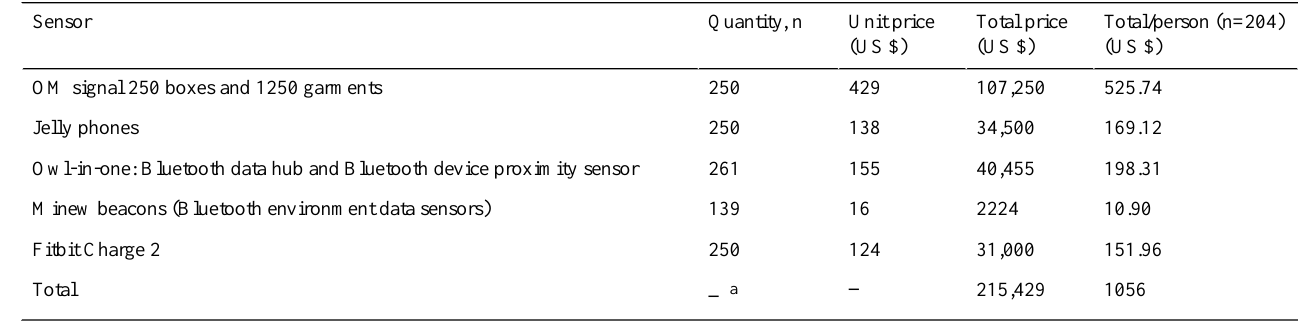
Table 3. Cost of sensors.